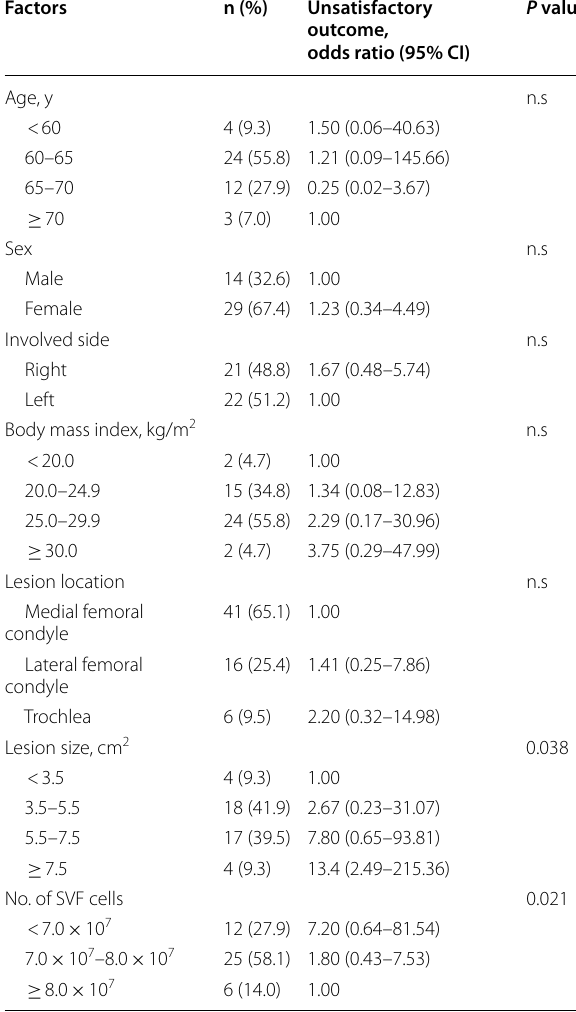
SVF Stromal vascular fraction, CI Confidence interval